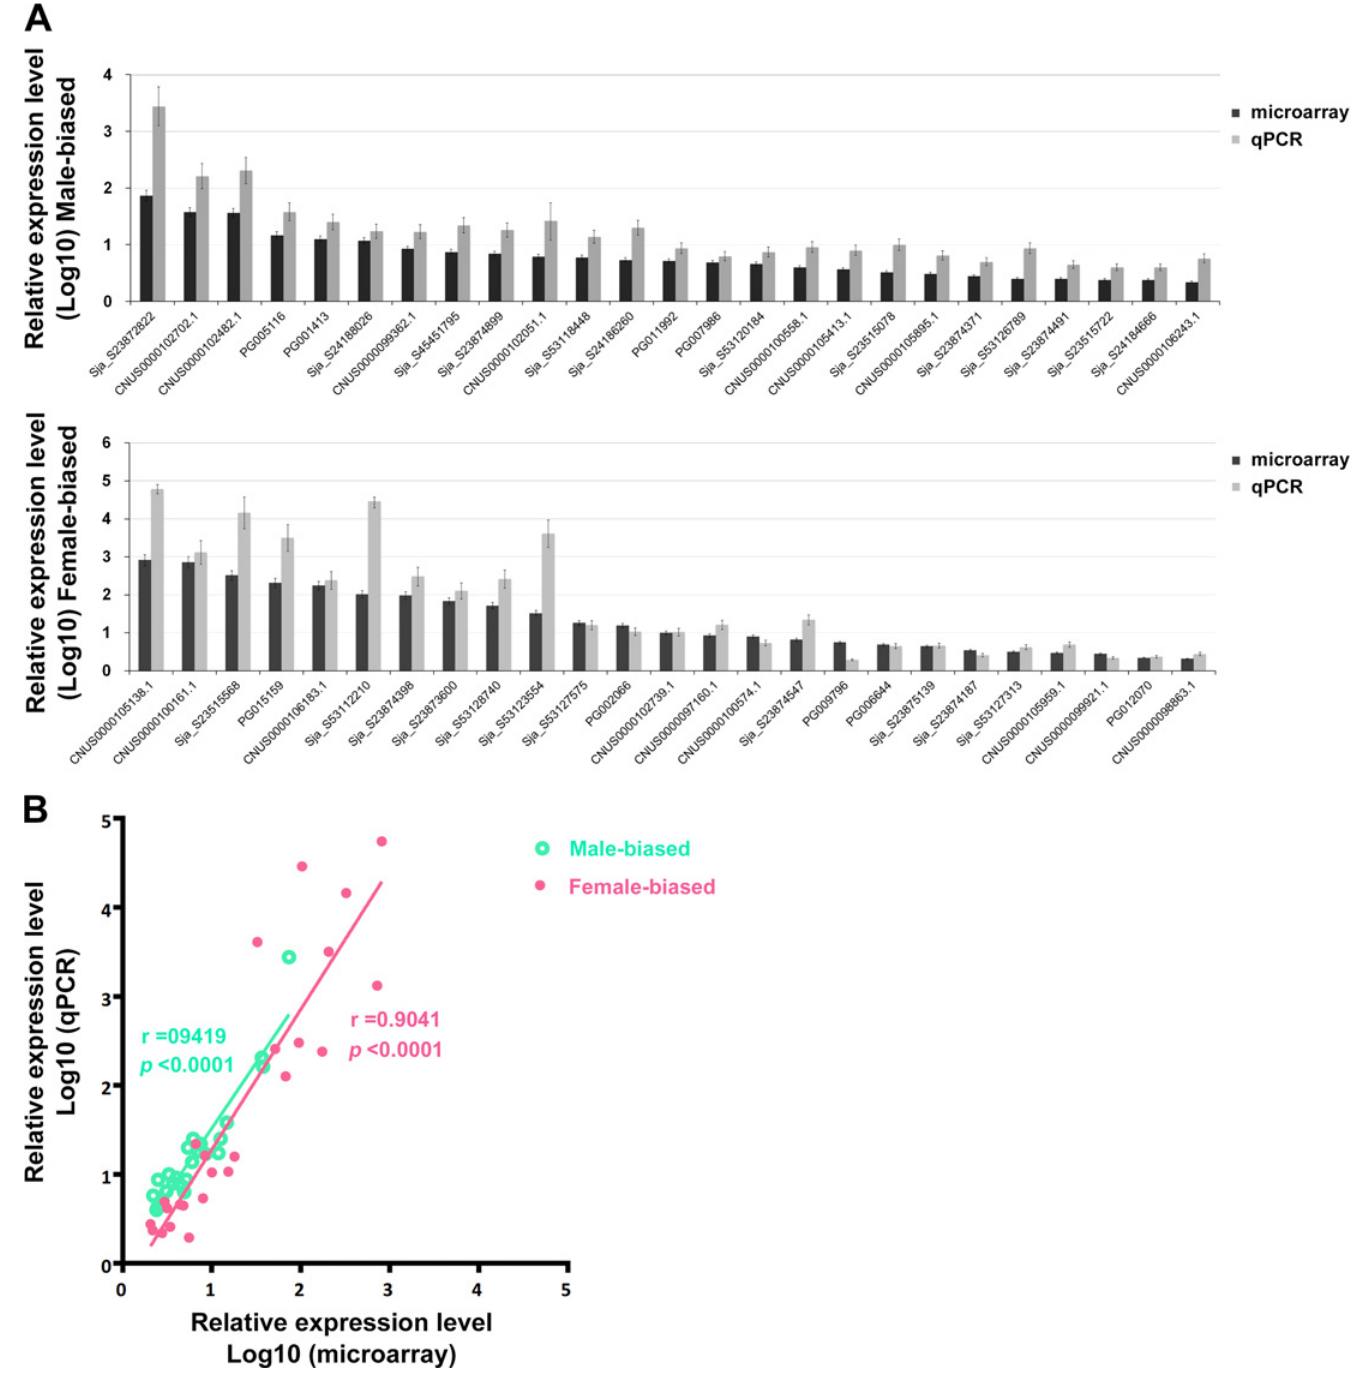
Fig 3. DNA microarray results validated by qPCR assays. A. Comparison of DNA microarray and qPCR results of 50 gender-associated genes. Upper panel, 25 adult male-associated genes; Lower panel, 25 adult female-associated genes. B. Correlations between the qPCR and microarray results of 50 gender-biased expressed genes were performed using Spearman ’ s Rho correlation. The log 10 ratio transformed data are shown.